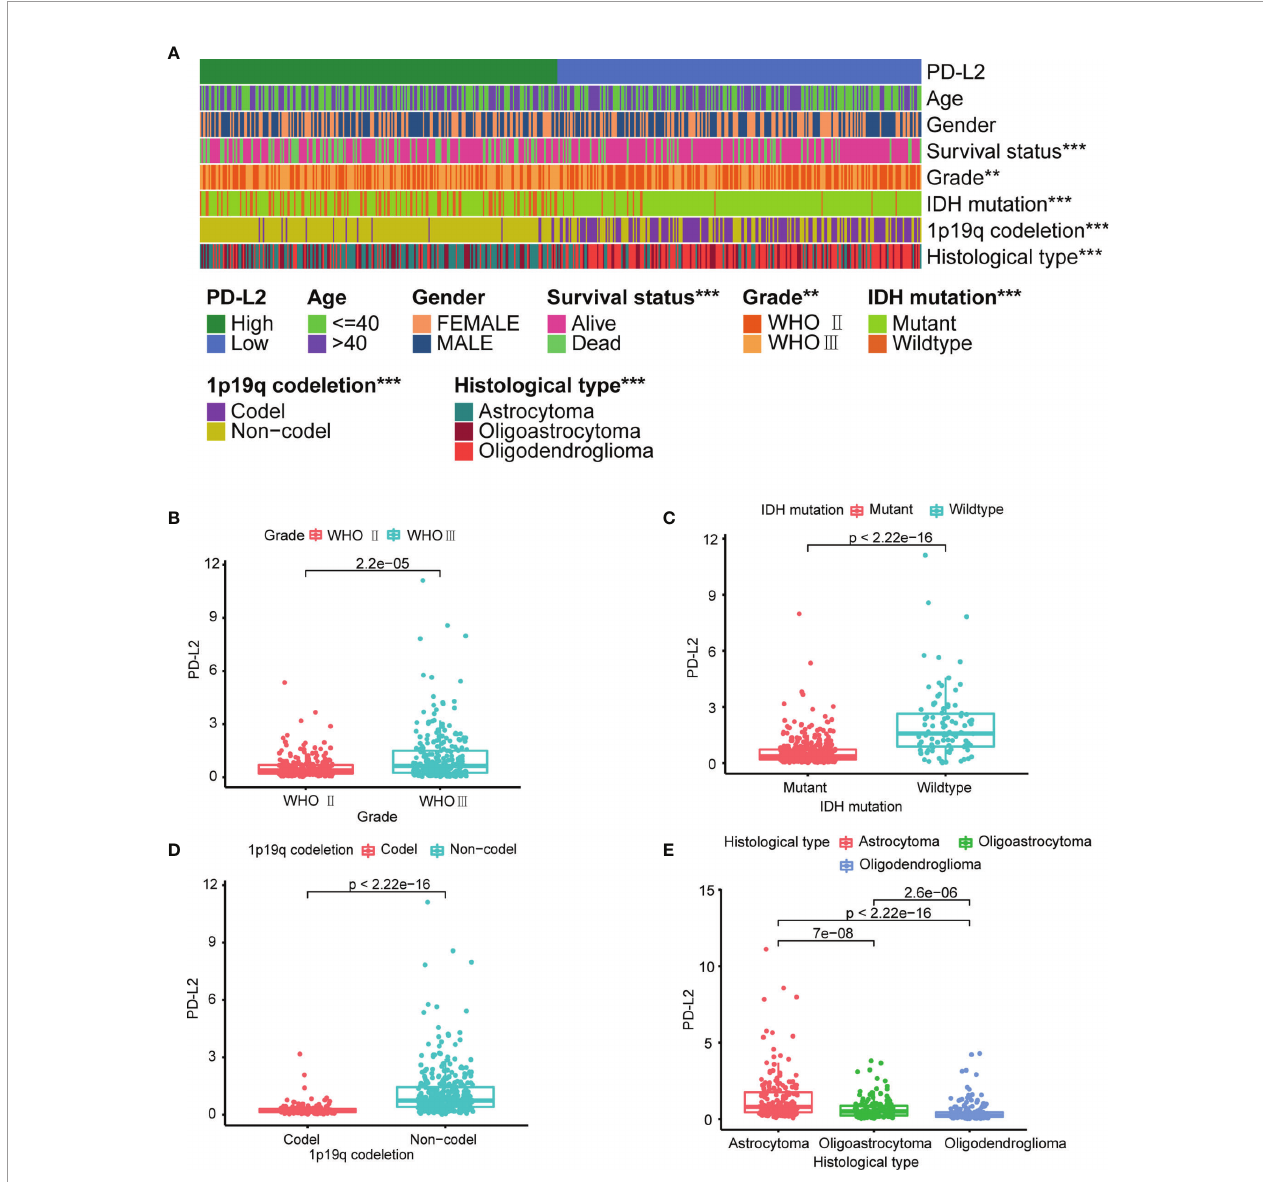
FIGURE 1 | PD-L2 expression is associated with clinicopathological features in the TCGA dataset. (A) The heatmap showing the correlation between the expression levels of PD-L2 and the clinicopathological features including age, gender, survival status, grade, IDH mutation status, 1p/19q codeletion status, and histological types. (B – E) The scatter diagram showed that grade, IDH mutation status, 1p/19q codeletion status and histological types were signi fi cantly associated with PD-L2 expression (***P<0.001;